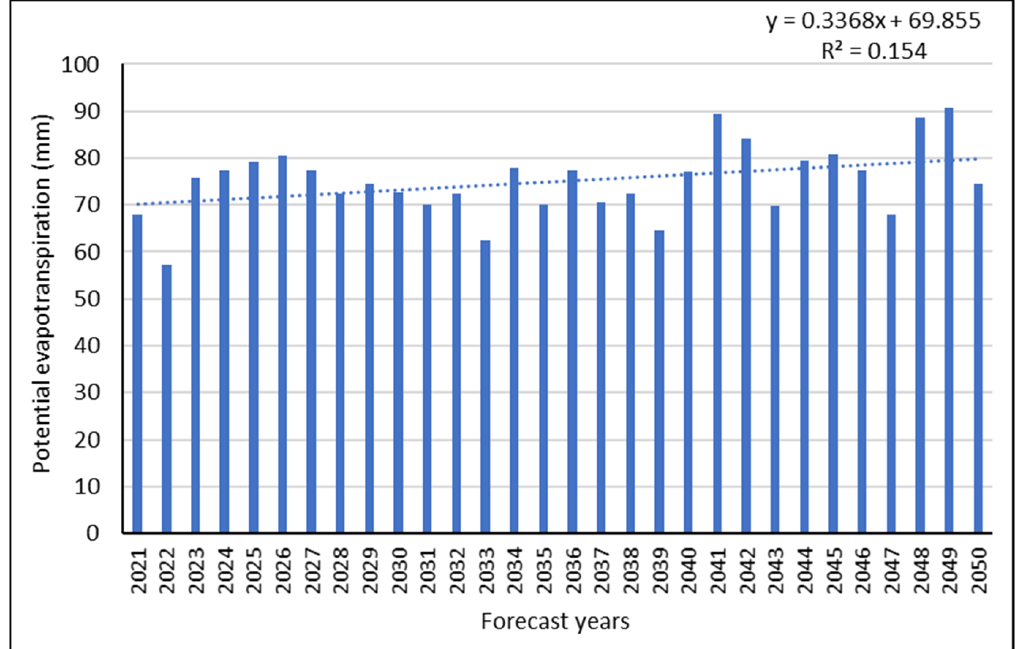
Figure 3. Time trend of Jerusalem artichoke water needs, expressed as potential evapotranspiration, in August in the forecast years 2021–2050; the dash line is the trend line. Table 6. Comparison of the Jerusalem artichoke water needs (mm) in the reference and forecast years.